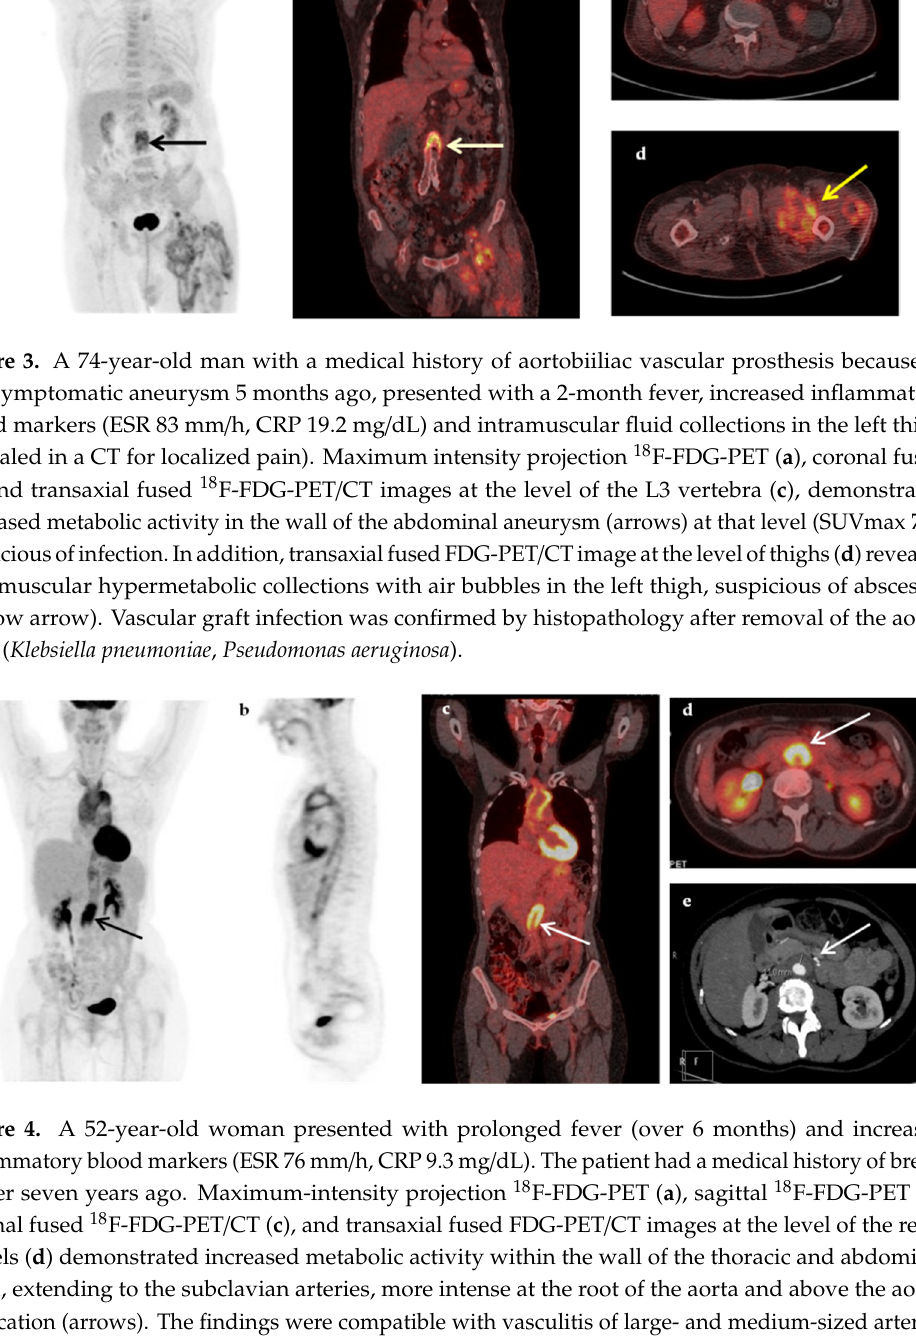
Figure 5. A 75-year-old woman presented with a 4-week fever associated with malaise and weight loss. The abdominal CT revealed splenomegaly and adrenal masses. Maximum-intensity projection (MIP) 18 F-FDG-PET ( a ) showed extensive highly hypermetabolic lymphadenopathy, cervical, axillary (SUVmax 22.7) and abdominal and hypermetabolic (SUVmax 16.8) adrenal masses (fused transaxial 18 F-FDG-PET/CT image ( b ), arrows), hypermetabolic hepatic lesions (at least two) and multiple hypermetabolic bone metastases and splenomegaly with diffuse homogeneously increased metabolic activity. The findings were suspicious of lymphoma. A diagnosis of non-Hodgkin’s lymphoma was confirmed by histopathology after biopsy of an axillary lymph node.